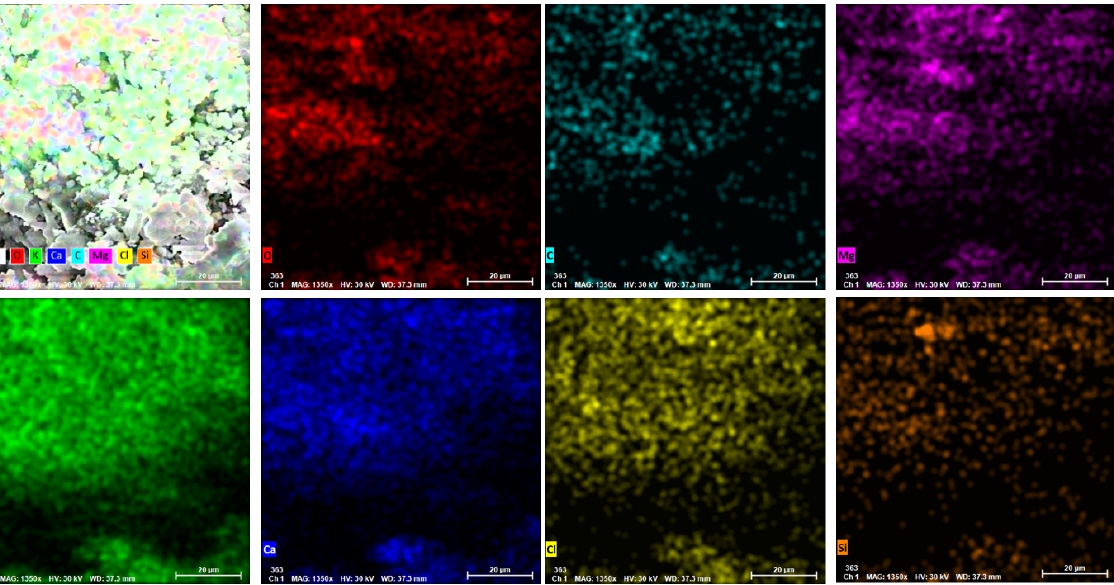
Figure 5. SEM images of the SA and cement at a magnification rate of 50 µ m ( left images) and of 10 µ m ( right images). In Figure 6 are presented the distributions of the main identified elements on a 0.01 mm 2 area: O, C, Mg, K, and Ca. Beside the general oxides mass, few small compounds based on Si or Cl could be observed.